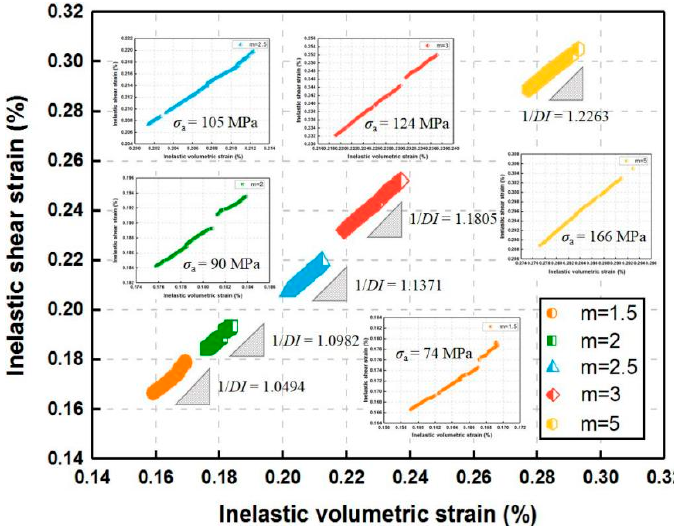
Figure 13. Strain path in inelastic shear strain vs. volumetric strain space for various homogeneity indexes during uniaxial creep loading.